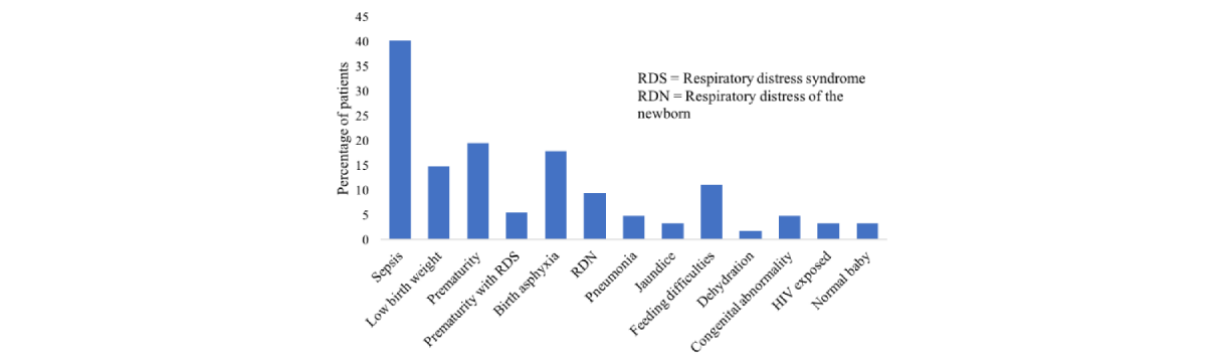
Figure 4. Provisional health care professional admission diagnoses (not mutually